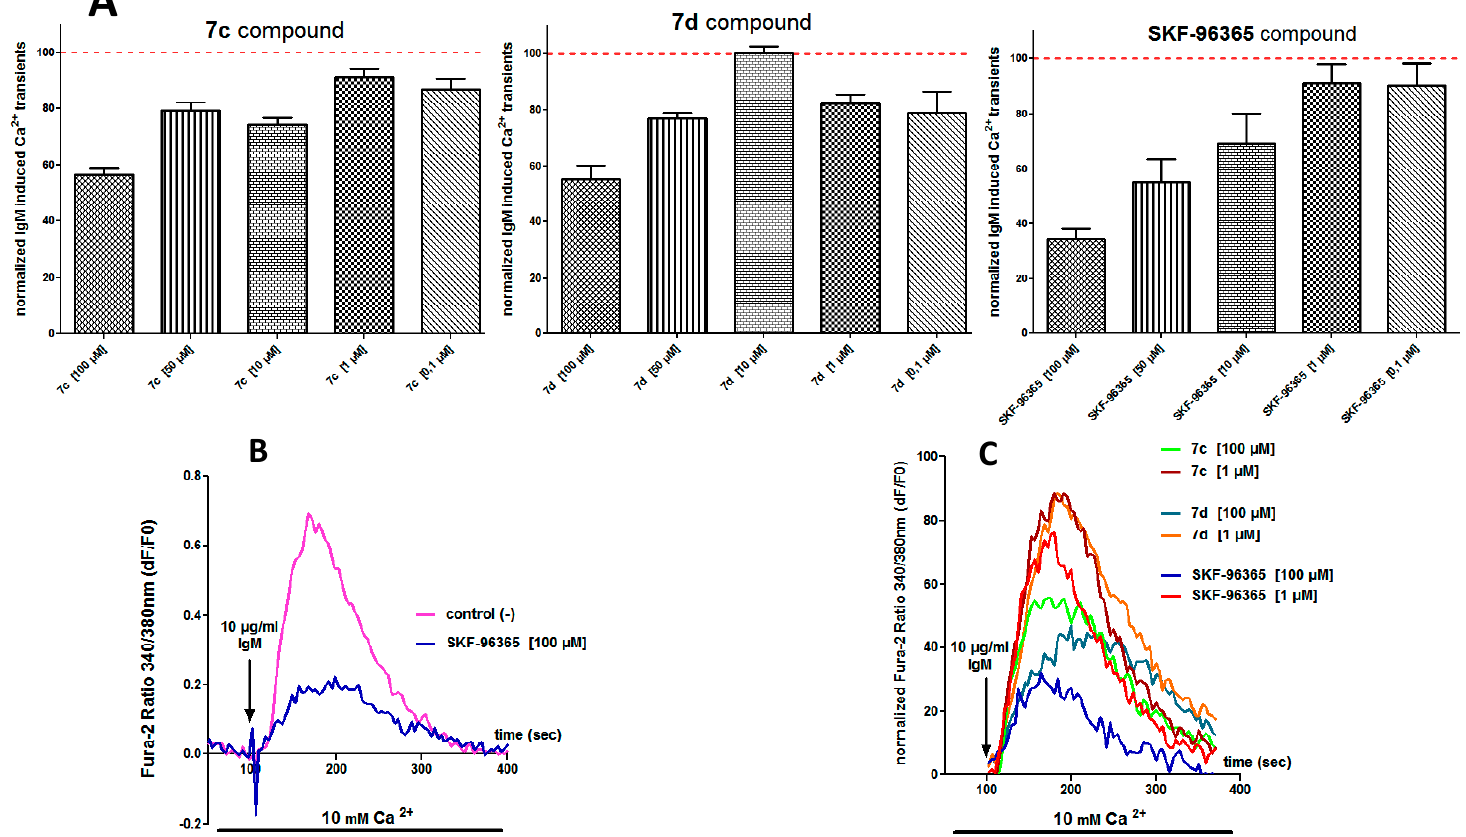
Figure 4. Effect of 7c , 7d , and SKF-96365 compounds on BCR (B Cell Receptor) induced Ca 2+ responses in B cells stimulated with IgM in the presence of extracellular Ca 2+ . ( A ) histograms represent the average inhibition of IgM-induced Ca 2+ transients in PLP cells treated with five different concentrations of 7c , 7d and SKF-96363 compounds (100, 50, 10, 1 and 0.1 μ M). Data are normalized to vehicle control (100%) and represented as the mean ± SEM of 3 different experiments; ( B , C ) panels show typical representative traces of intracellular Ca 2+ concentration variations measured with Fura-2 dye in PLP cells with BCR activation stimulation by IgM in the presence or absence of the different tested drugs. Tested compounds 7c , 7d , and SKF-96365 were added 3 min before recording intracellular Ca 2+ level variation. BCR-induced Ca 2+ responses are measured in 10 mM Ca 2+ extracellular medium in cells stimulated with 10 μ g/mL IgM; ( B ) Representative traces obtained in control ( − ) conditions or in the presence of SKF-696365 (100 μ M); ( C ) Representative traces normalized to control conditions in cells treated with 7c , 7d , and SKF-96365 compounds (100 and 1 μ M).